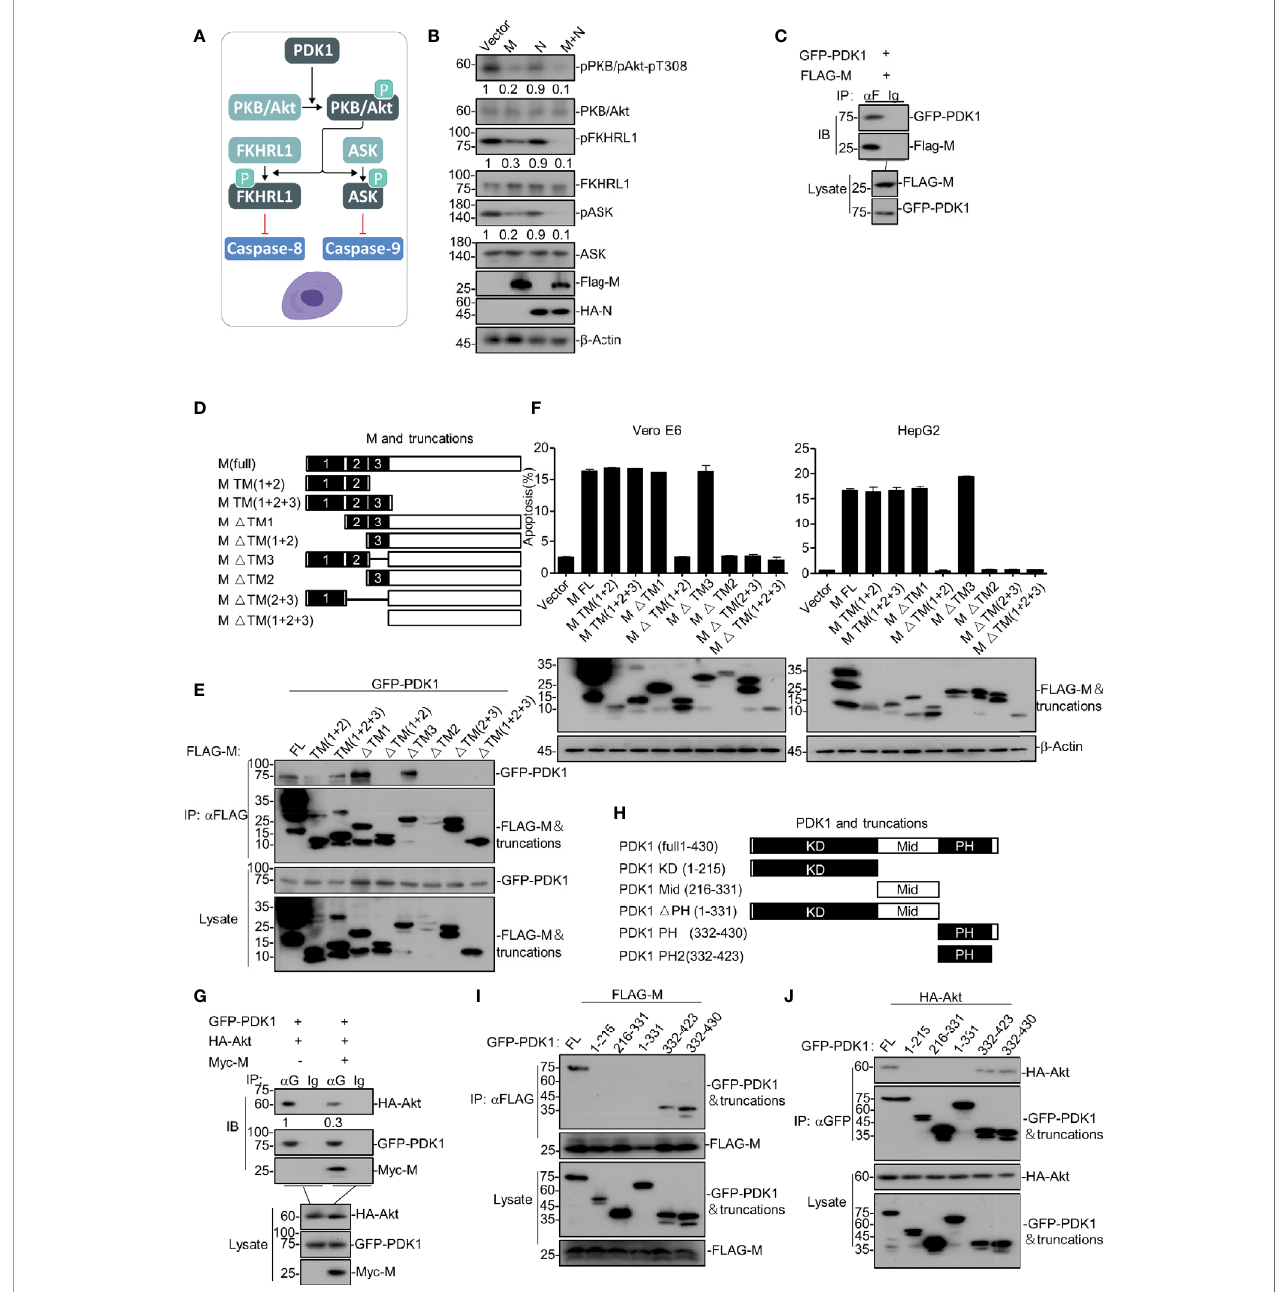
FIGURE 2 | SARS-CoV-2 M induces apoptosis via down-regulating PDK1-PKB/Akt signaling. (A) A model of PDK1-PKB/Akt signaling associated with apoptosis. (B) HEK293T cells were transfected with FLAG-SARS-CoV-2 M, HA-SARS-CoV-2 N, and FLAG-SARS-CoV-2 M plus HA-SARS-CoV-2 N. 24 h later, cells were collected for Western blotting with antibodies to the indicated proteins. (C) HEK293T cells transfected with FLAG-SARS-CoV-2 M together with GFP-PDK1. After 24 h, cells were collected for co-immunoprecipitation (with anti-FLAG or IgG) and Western blotting (with anti-GFP or anti-FLAG). (D) Schematic representation of SARS-CoV-2 M and its truncations. (E) HEK293T cells transfected with FLAG-SARS-CoV-2 M and its truncations together with GFP-PDK1. After 24 h, cells were collected for co-immunoprecipitation (with anti-FLAG) and Western blotting (with anti-GFP or anti-FLAG). (F) Vero E6 and HepG2 cells were transfected with FLAG- SARS-CoV-2 M and its truncations. 24 h later, cells were collected for Western blotting (with anti-FLAG or anti- b -Actin) or stained with Annexin V-FITC/PI for fl ow cytometry analysis. The percentage of apoptotic cells was measured. (G) HEK293T cells transfected with FLAG-SARS-CoV-2 M and HA-Akt together with vector and GFP-PDK1, respectively. After 24 h, cells were collected for co-immunoprecipitation (with anti-GFP or IgG) and Western blotting (with anti-GFP, anti-Myc, or anti-HA). (H) Schematic representation of PDK1 and its truncations. (I, J) HEK293T cells transfected with GFP-PDK1 and its truncations together with FLAG-SARS- CoV-2 M and HA-Akt, respectively. 24 h later, cells were collected for co-immunoprecipitation (with anti-GFP) and Western blotting (with anti-GFP, anti-HA, or anti- FLAG). The densities of blots were analyzed with ImageJ